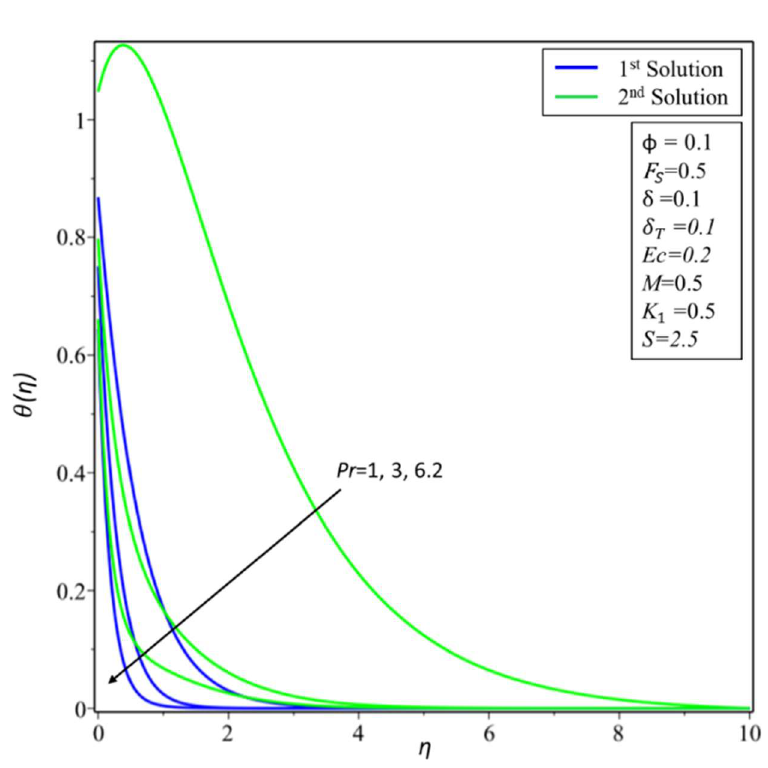
Figure 11. Changes of 𝜃(𝜂) for 𝑃𝑟 .